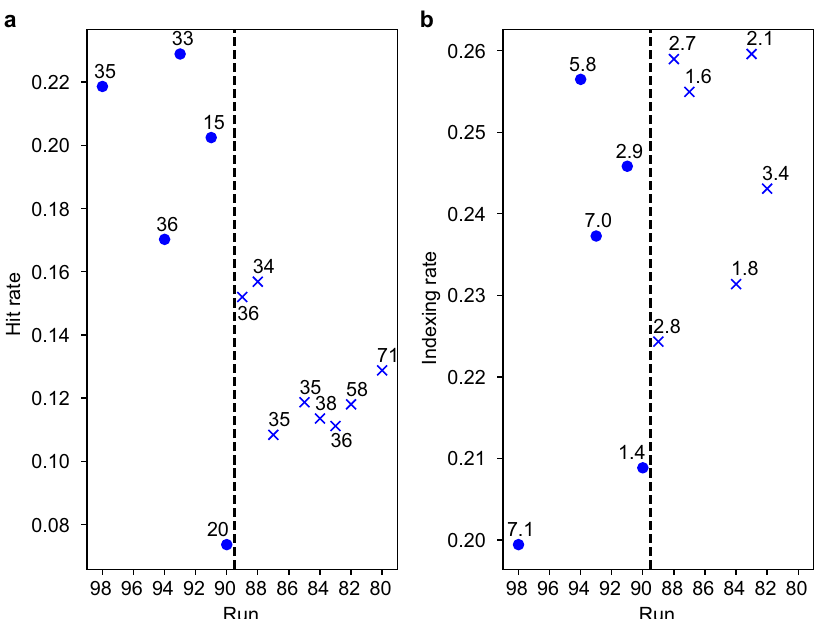
Fig. 2 Hit and indexing rates in pump – probe and probe-only runs. a Hit rate as a function of run number for single-pulse (circles) and pump – probe (crosses) runs. The hit rate was calculated as the number of hits divided by the number of shots comprising a run. The average value of the hit rate is 13% in the pump – probe data set and 19% in the single-pulse data set. All hits prior to fi ltering were taken into account (43,003 hits for the pump – probe and 25,742 hits for the single-pulse data set). The number above each data point indicates the number (in thousands) of X-ray shots per run. b Indexing rate as a function of run number for single-pulse (circles) and pump – probe (crosses) runs. The indexing rate was calculated as the number of indexed hits divided by the total number of hits in a run. The average indexing rate was 24% in the pump – probe data set and 23% in the probe-only data set, leading to 3531 and 5541 indexed images in the pump – probe and single-pulse data set, respectively. Only hits satisfying the diode signal and jet image fi ltering conditions (see “ Methods ” section) were taken into account. The number above each data point indicates the number (in thousands) of indexed hits per run. For two runs (run 80 and 85), the jet imaging time delay varied and the jet images could thus not be analysed as to whether a shock wave had been launched that could successfully propagate to the jet segment to be probed. Therefore, all hits from these runs were excluded from the analysis and the post- fi ltering indexing rate is not de fi